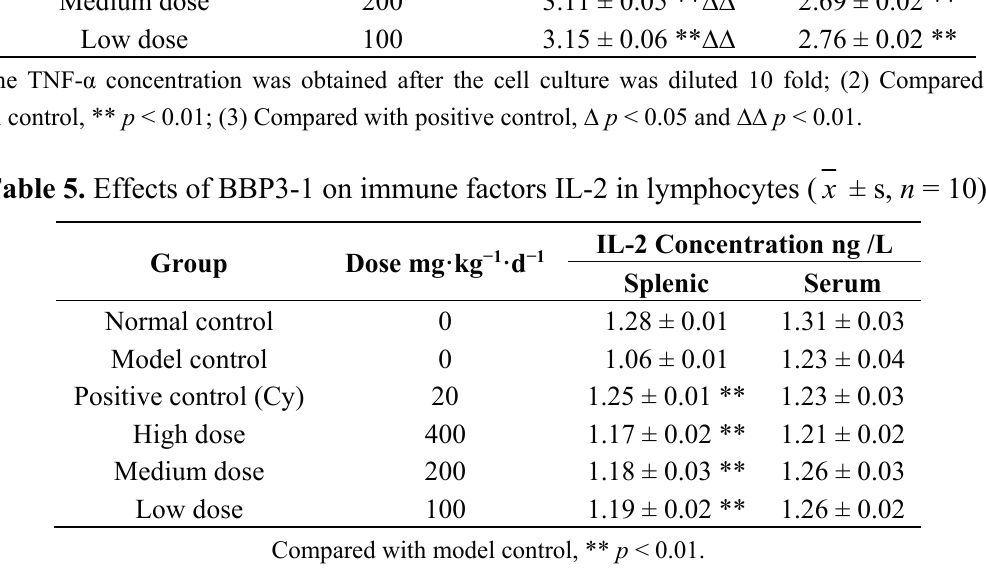
Compared with model control, ** p < 0.01.